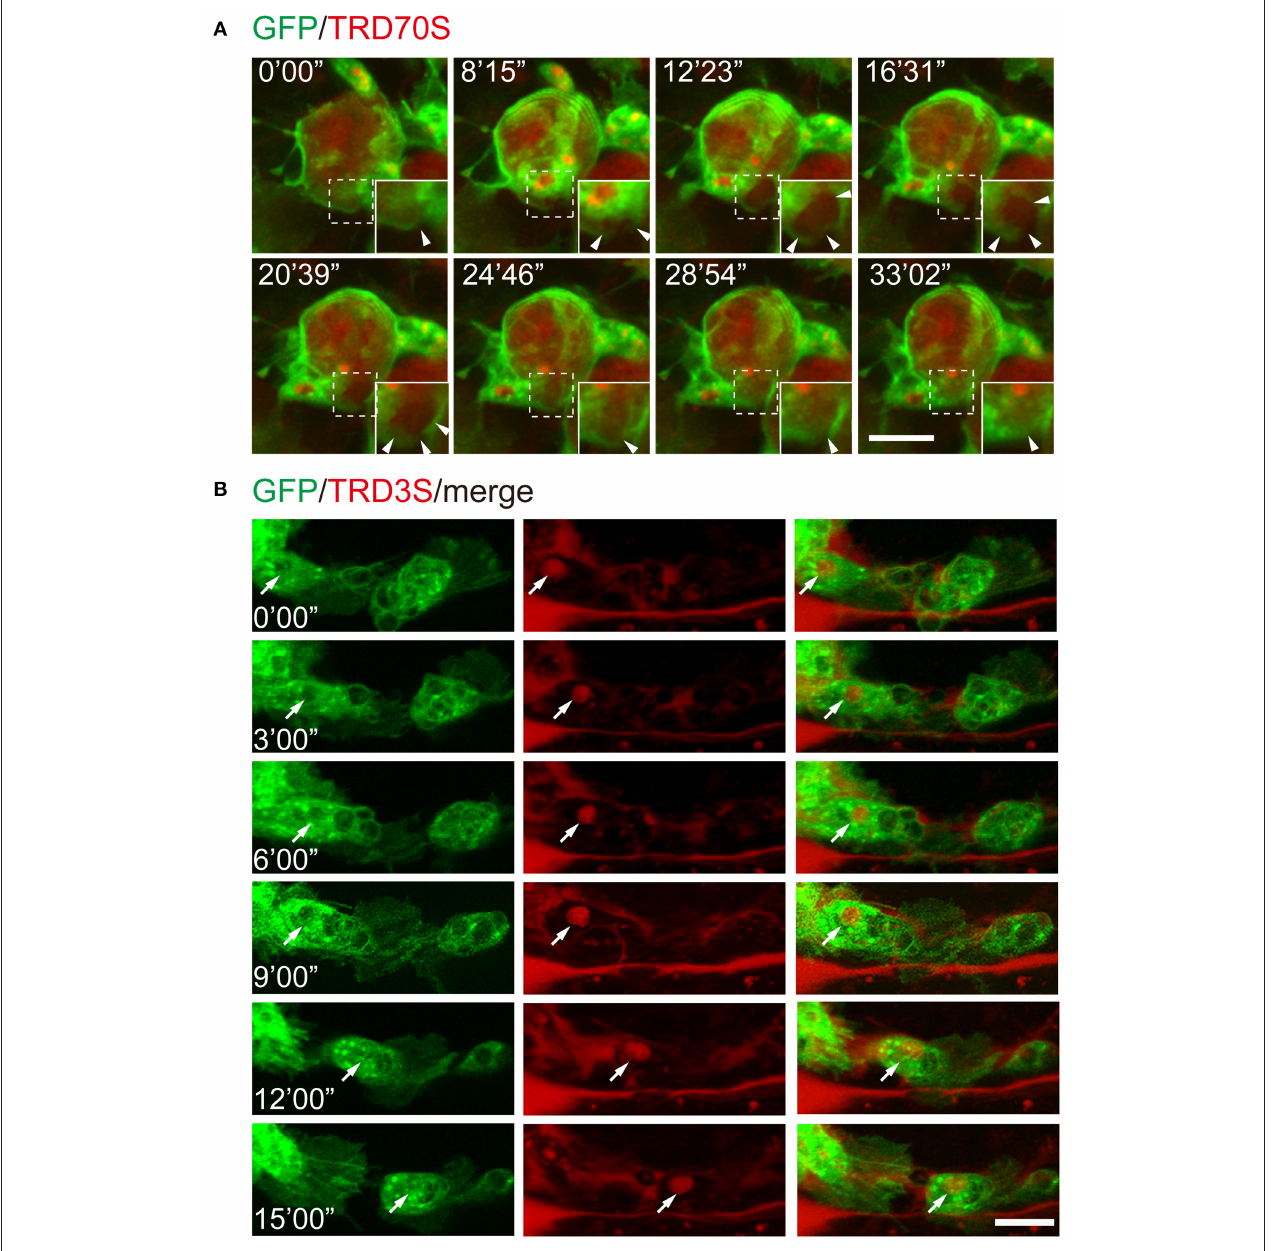
FIGURE 4 | Recording of cellular and subcellular behaviors using the ATP γ S microinjection-based imaging system. (A) Dynamic changes of macropinosomes, from formation to fusion. Note that macropinosomes (red) were formed from the surface membrane ruffles and internalized after enclosure (arrowheads). The newly formed macropinosomes were indicated by dashed boxes and corresponding enlarged parts were presented at right corners. (B) TRD3S macropinosomes (red) transported within migrating hemocytes (green). The arrow indicates the location of a trafficking vesicle. Scale bars, 10 µ